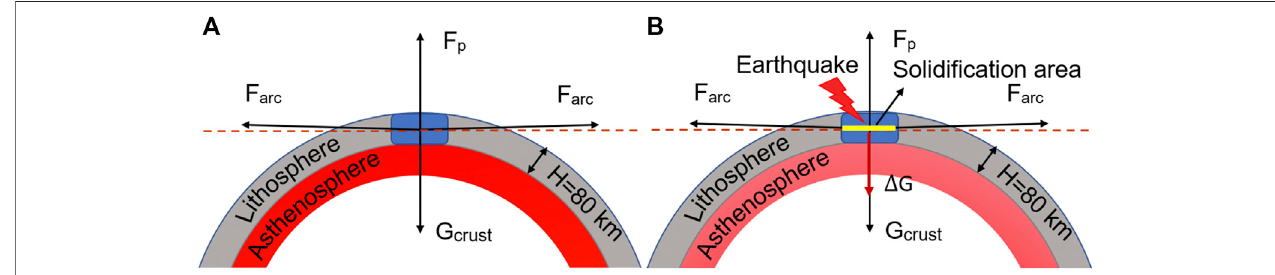
FIGURE 6 | The mechanical models of the Earth before and after solidi fi cation. Red shading: density of magma, a darker color implies greater density; F P denotes supportingtheforceofasthenosphere,andF arc denotesthecircumferentialforce. (A) Themechanicalstructureoftheoverlyingcrustisbalancedbeforesolidi fi cation. (B) When the magma continues solidifying, it accumulates the weight of the overlying crust, and the mechanical structure of the overlying crust becomes unstable when its limit load is reached, causing collapse and rupture and triggering an earthquake.